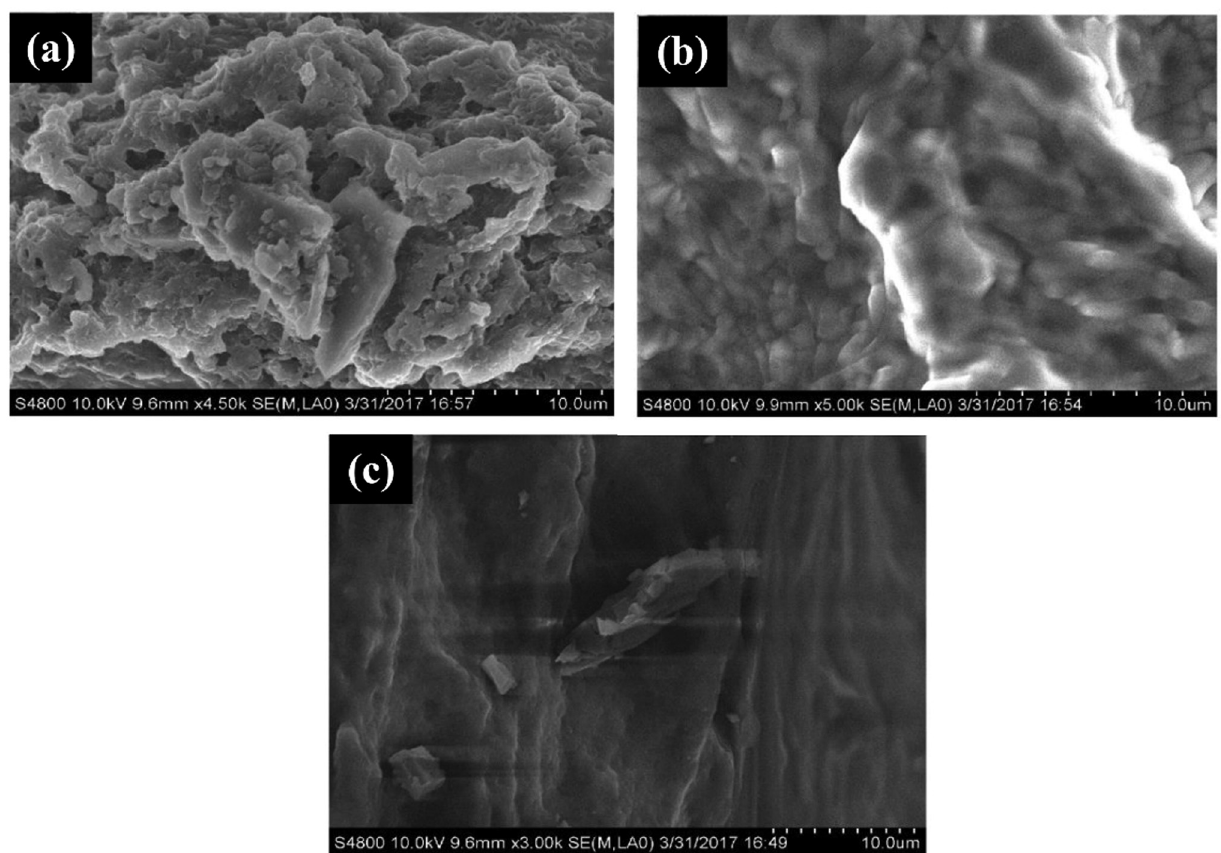
Figure 2: SEM of ( a ) pure POEA, ( b ) 0.5 g chitosan/CH - POEA composite, and ( c ) 1 g chitosan/CH -